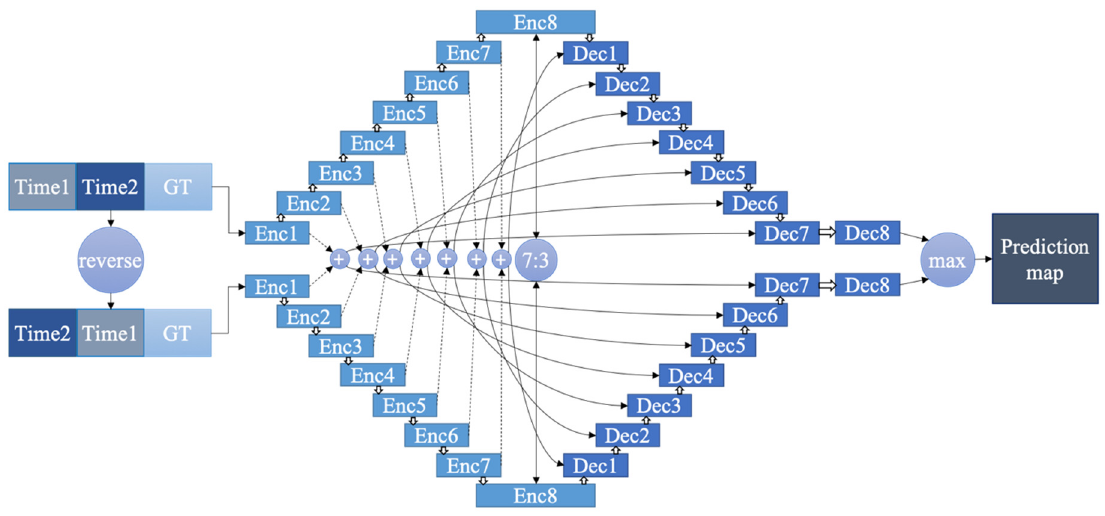
Figure 2. Architecture of CORN with an additional skip connection to both decoder sides.